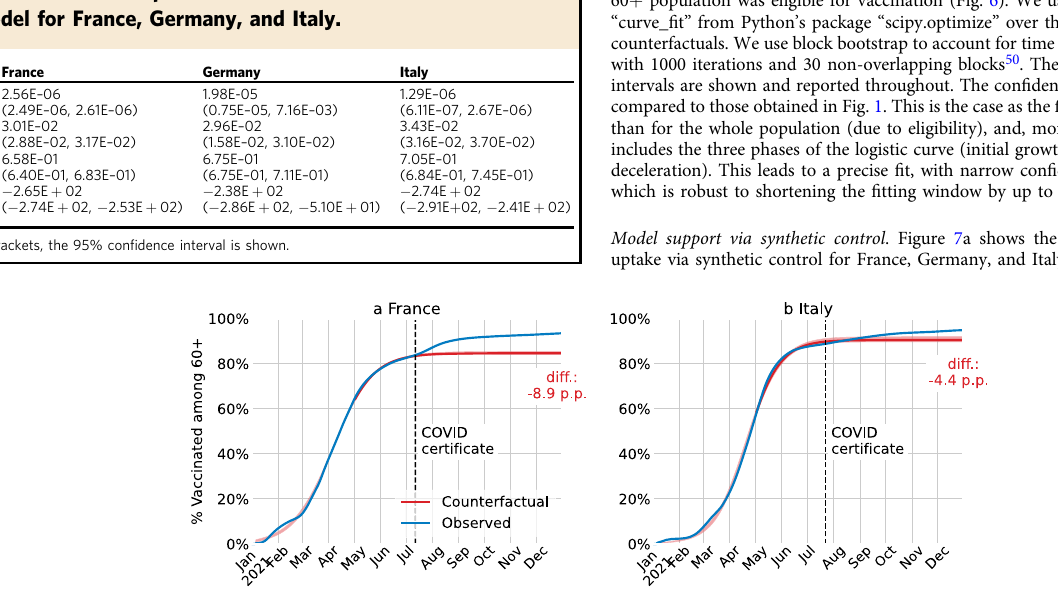
Fig. 6 Realised and counterfactual vaccination rates for the population over age 60. For France ( a ) and Italy ( b ), cumulative proportion of the population over age 60 who received at least one COVID-19 vaccine dose in the actual intervention deployment (blue) and in the no-intervention counterfactual scenario (red). The red shaded area is the 95% con fi dence interval centred around the main estimate. The counterfactual scenario is estimated via innovation diffusion theory. The black dashed vertical line is the date of the announcement of the COVID certi fi cate.